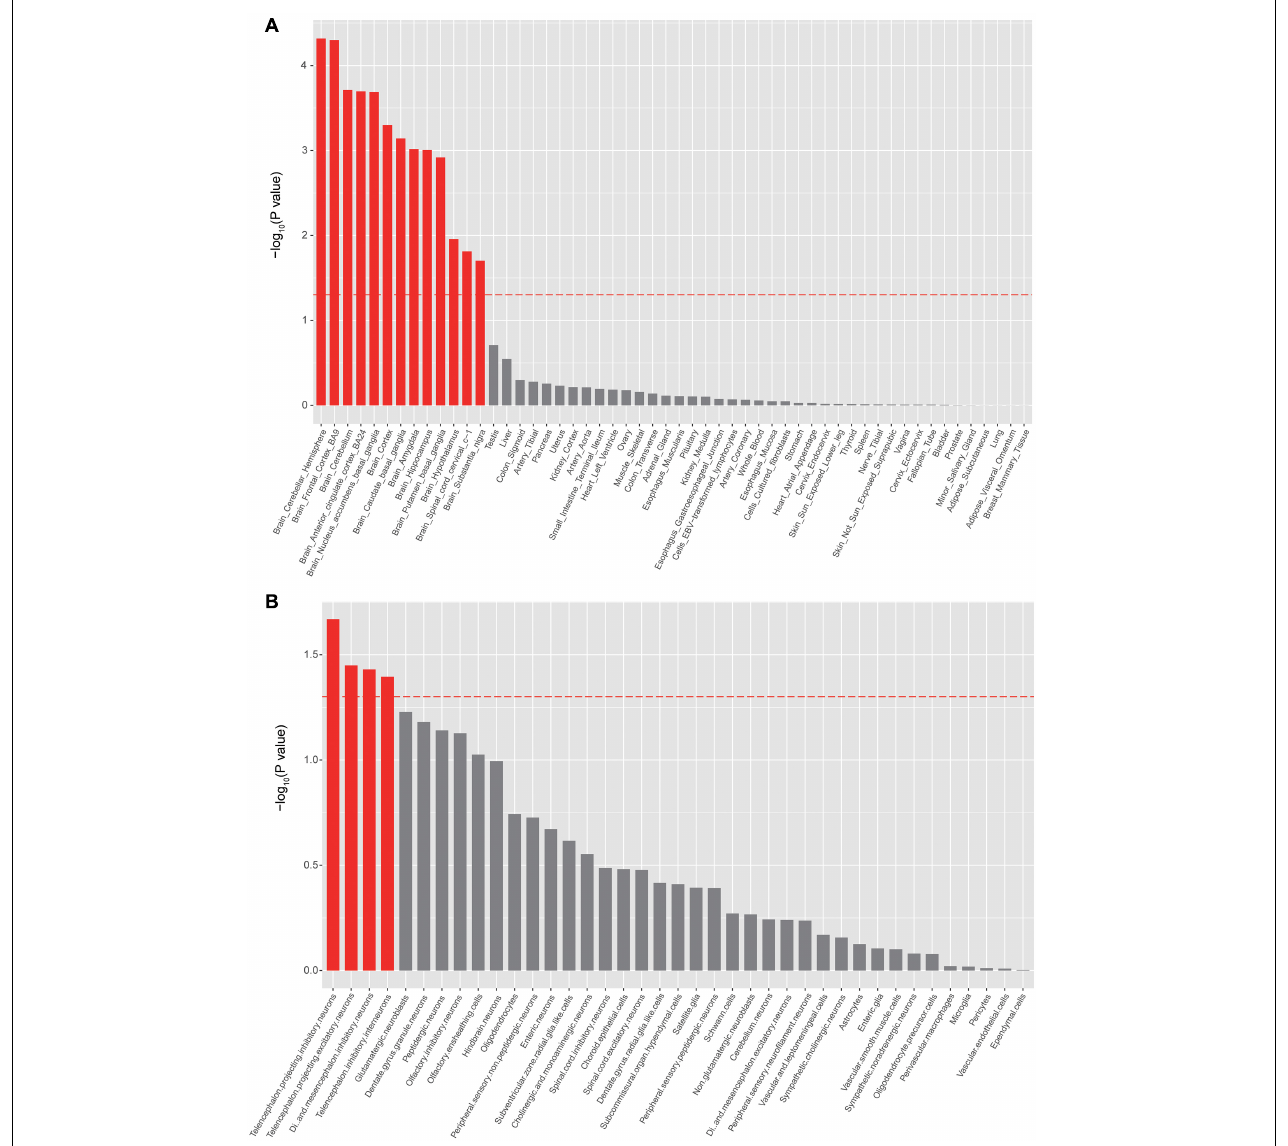
FIGURE 3 | Tissue- and cell-type enrichments of epilepsy GWAS associations. (A) Tissues that showed significant enrichment (corrected p < 0.05) are shown in red. (B) Cell types that showed significant enrichment (corrected p < 0.05) are shown in